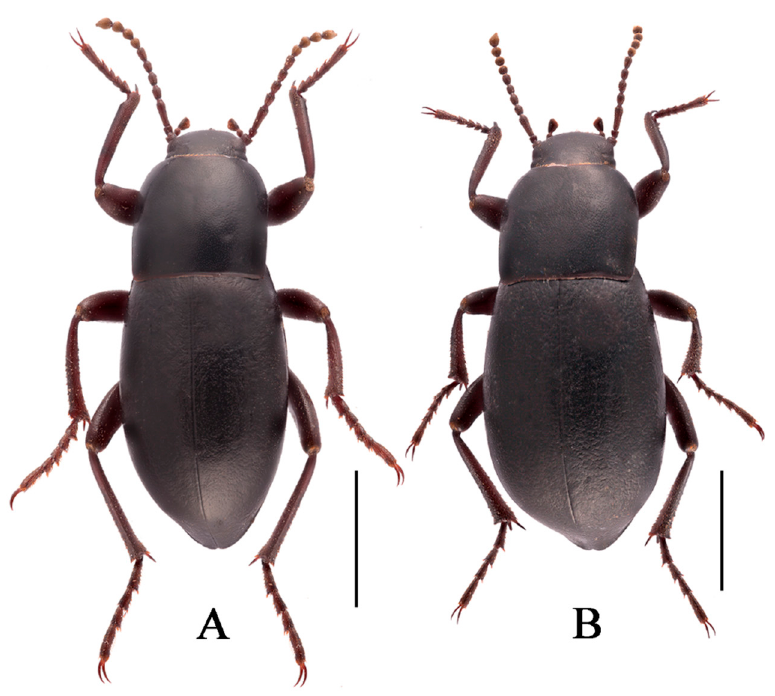
Figure 12. Habitus of N. yushuensis sp. n. (( A ) male, holotype; ( B ) female, paratype). Scale bars: 5.0 mm.